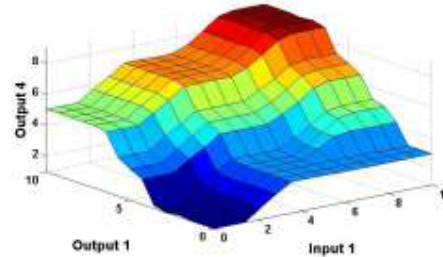
Figure 14. Surfaces of the fuzzy logic subsystem 4.